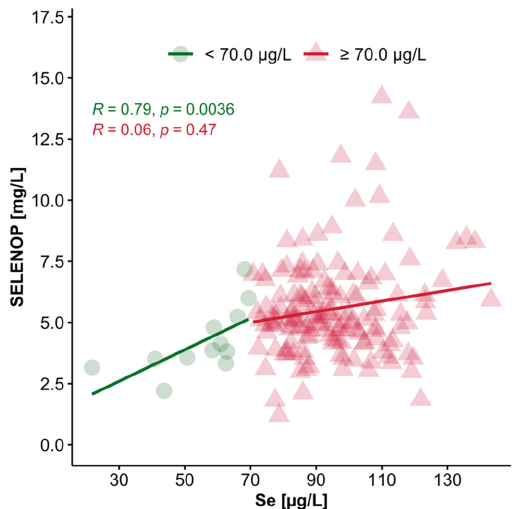
Figure 2. Correlation analysis of plasma Se with SELENOP concentrations. All of the available plasma samples ( n = 134) of the patients enrolled were analysed for total plasma Se and SELENOP concentrations. The samples were separated into two groups based on total plasma Se deficiency into Se-deficient (<70 µg/L, green) and Se-replete (>70 µg/L, red). The biomarkers showed a significant and positive linear correlation (Spearman, R = 0.79, p = 0.0036) in the Se-deficient samples, whereas Se-replete subjects revealed a non-significant, positive correlation (Spearman, R = 0.06, p = 0.47).